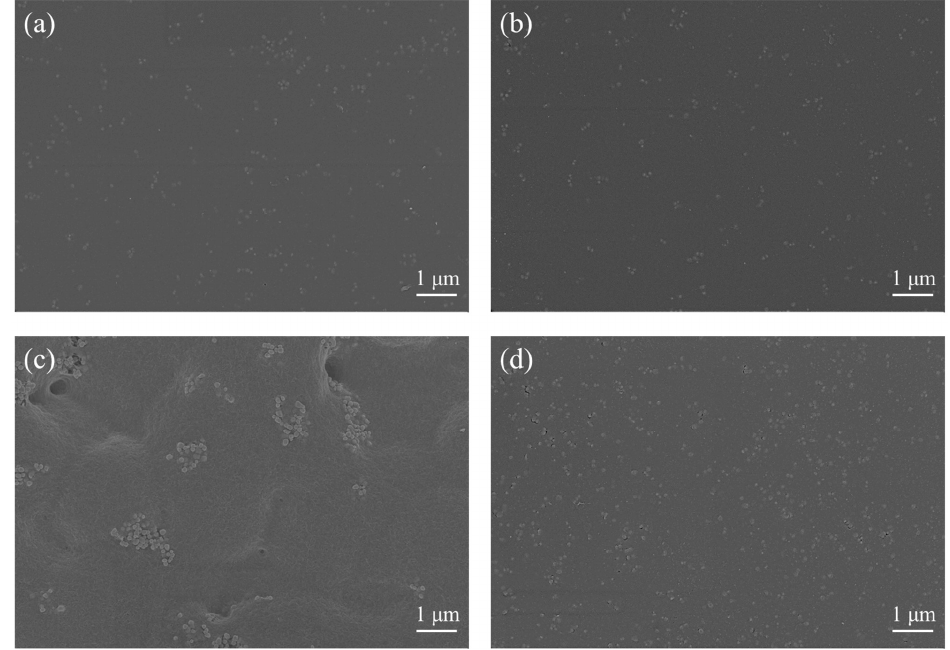
Figure 4. FESEM images of the surfaces of the printed composite films: ( a ) 10% BTO/PVDF, ( b ) 10% TOS-BTO/PVDF, ( c ) 20% BTO/PVDF, and ( d ) 20% TOS-BTO/PVDF. The β-phase content determines the piezoelectricity of PVDF. The crystalline phase composition of the as-prepared samples was investigated using XRD to validate the changes in the phase composition of PVDF. Figure 5a shows the XRD patterns of the as- printed nanocomposites with different BTO nanoparticle weight fractions. The typical characteristic peaks of pure PVDF are at 2θ = 18.3° and 26.5°, which are related to the α- phase of PVDF. The (020) and (021) reflections of PVDF were attributed to these two peaks. In addition, seven distinct diffraction peaks were clearly observed in the XRD pattern, which corresponds to the reflections of the (200), (100), (110), (111), (200), (210), and (211) crystal planes. The appearance of these peaks in the nanocomposite XRD patterns shows that the crystalline characteristics of the TOS-BTO nanoparticles correspond to a ferroe- lectric tetragonal phase, and the crystal phase of TOS-BTO nanoparticles was not changed by the TOS surface modification. After blending the TOS-BTO nanoparticles with the PVDF polymer, the intensity of the α-phase peak decreased significantly. Accordingly, the diffraction peaks at 20.5°, corresponding to the reflection of the sum of the (110) and (200) crystal planes, confirm the emergence of the crystal β-phase in the TOS-BTO/PVDF nanocomposite, whereas the related peaks of BTO/PVDF are not visible. The findings re- veal that the TOS-BTO nanoparticles may operate as nucleation agents in the nanocom- posite film, promoting better dipole alignment and the formation of higher β-phase con- tent in the PVDF. Furthermore, by calculating the ratio of the intensities (I 20.3 and I 18.3 ), the β-phase and α-phase contents can be qualitatively estimated, as shown in Figure 5b. The surface-modified BTO nanoparticles significantly influenced the β-phase content. Com- pared to the pristine BTO/PVDF composite film, which exhibits I 20.3 /I 18.3 ratios of 3.4 and 4.5 corresponding to 10% and 20% BTO nanoparticles, respectively, the TOS-BTO/PVDF composite displays I 20.3 /I 18.3 ratios of 4 and 5.3 corresponding to 10% and 20% TOS-BTO